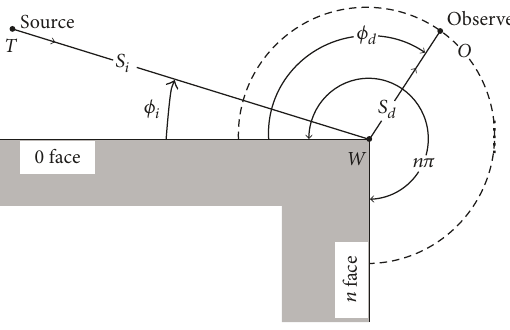
Figure 1: Geometry and wedge di ff raction